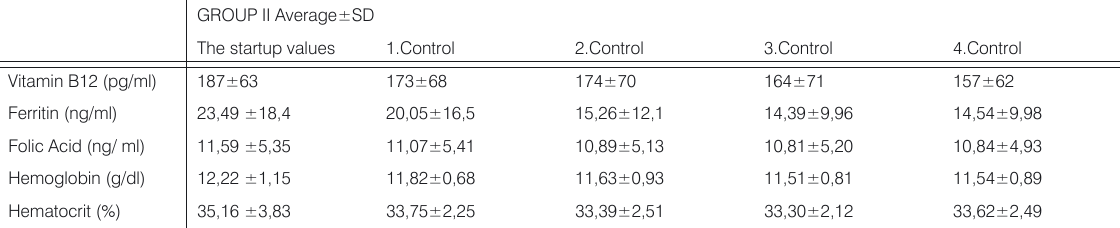
Table 3. Blood Analysis Values of Group II.